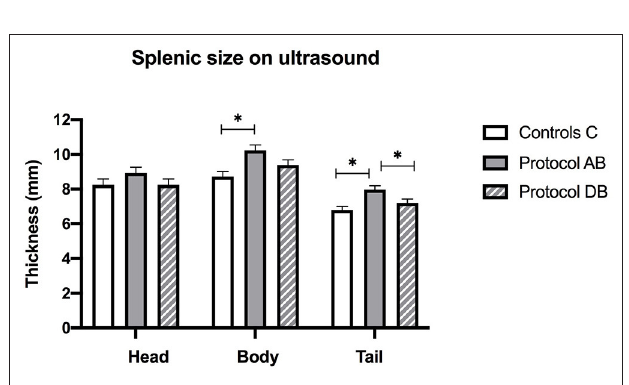
FIGURE 5 | Splenic thicknesses recorded on ultrasound at the three sites (head, body and tail) for the controls and after administration of protocol AB and DB. *Significant differences according to Tukey’s post-hoc tests ( p < 0.05). Bars represent the standard error of the mean (SEM).